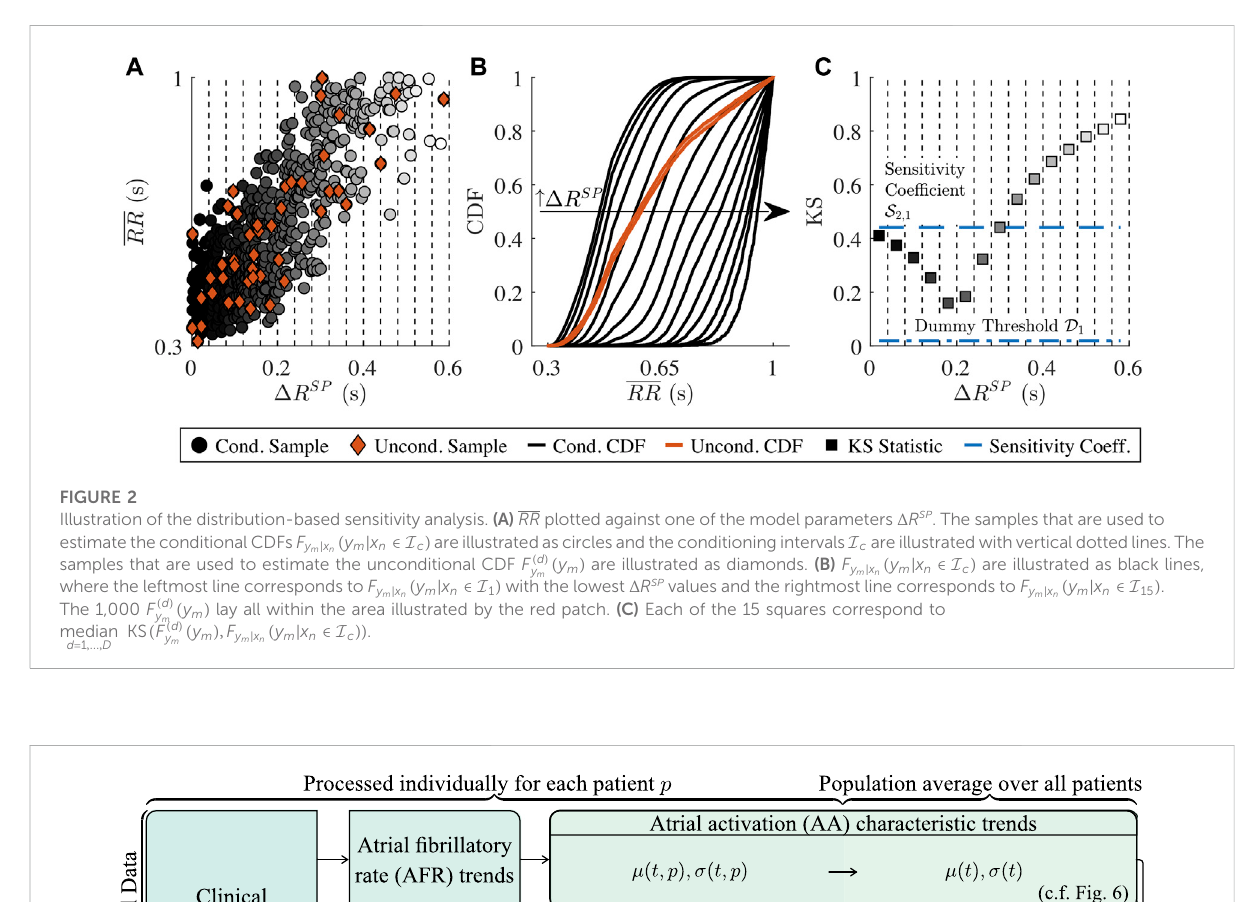
FIGURE 3 Schematic illustrating how the clinical and simulated RR series characteristic trends are